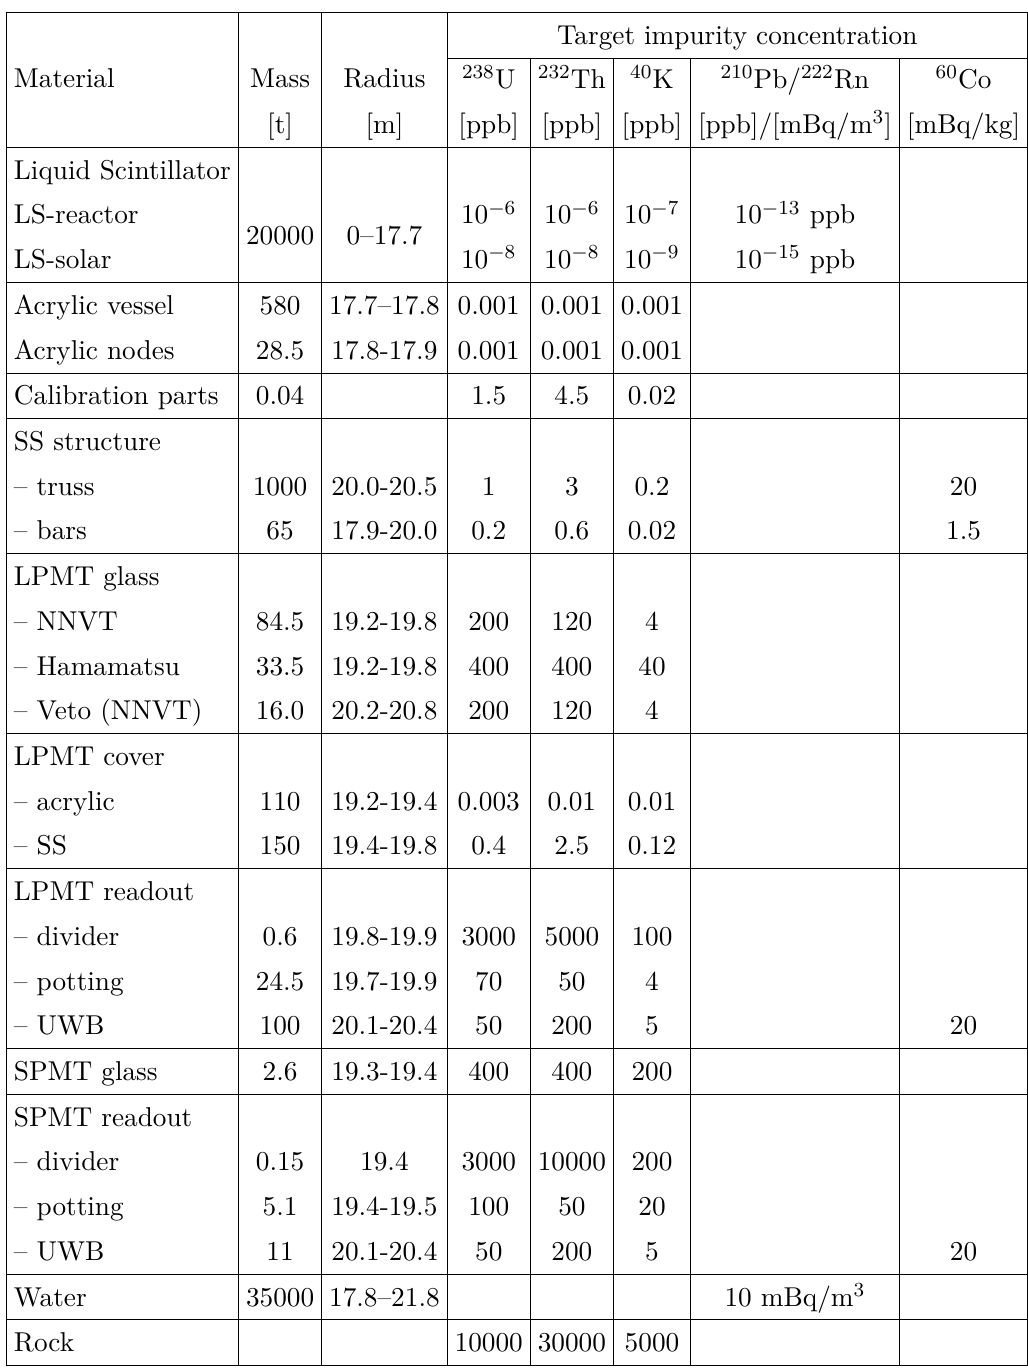
Table 1. Target values for the impurity concentrations in the different detector materials of the JUNO detector. For each detector component, the mass and its geometrical position, i.e. the radius quoted from the center of the LS volume, are reported. LS-reactor refers to the target impurity values required for mass hierarchy determination, whereas LS-solar refers to the target impurity values for solar neutrinos